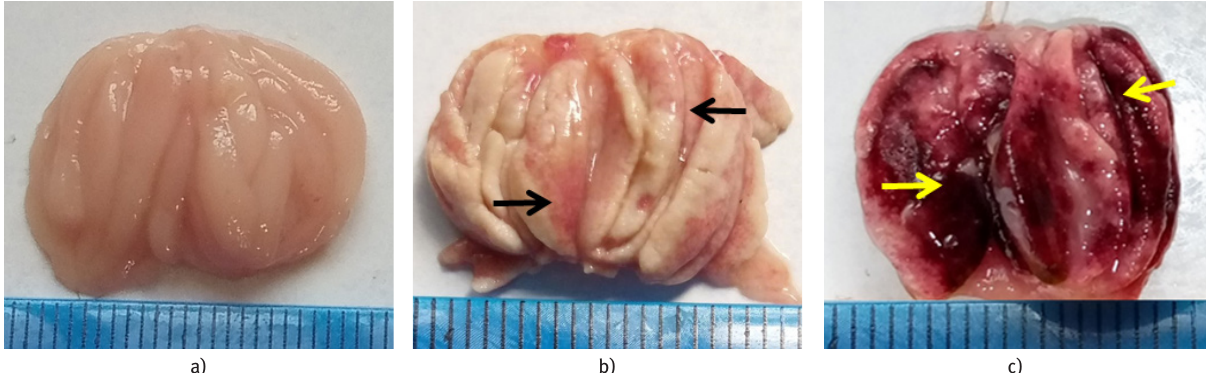
Figure 2: Photograph of bursal plicae of chickens post-inoculation and/or exposure to a very virulent infectious bursal disease virus. Note intact plicae in group A (a), congested plicae (arrows) in group B (b), haemorrhagic plicae (arrows) in group C (c)